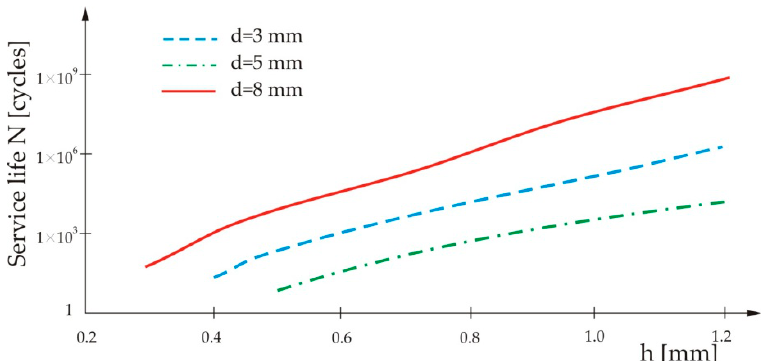
Figure 5. Influence of Thin Sheet 1’s thickness on the service life of the spot-weld for three di ff erent nugget diameters.